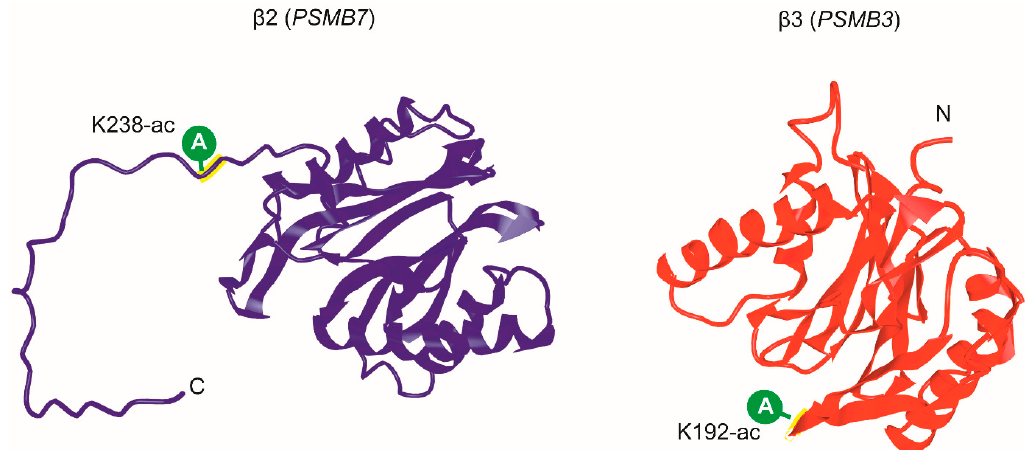
Figure 2. The structure of proteasome subunits with post-translational modifications detected by MALDI-ICR mass spectrometry. A—acetylation. Table 1. Potential modifications of cellular and extracellular proteasomes identified by MALDI FT- ICR MS.